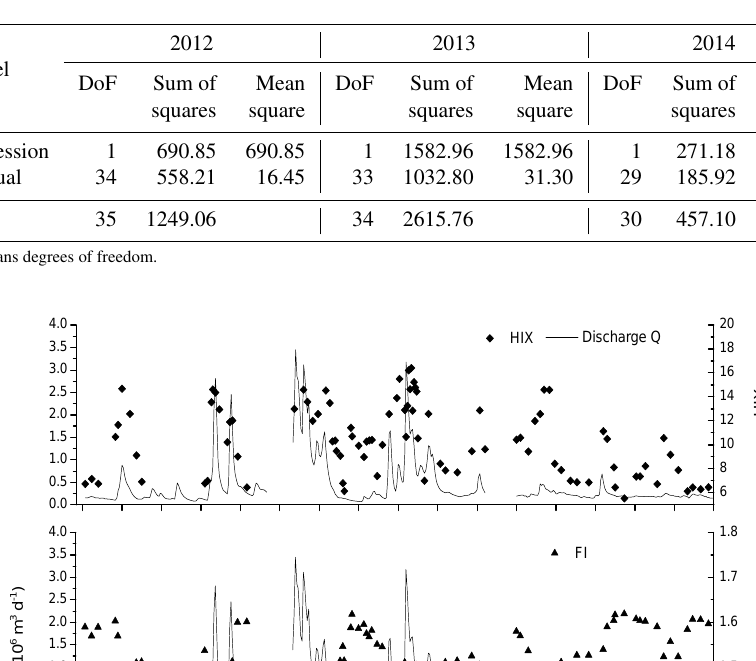
real regions. In our study, the annual mean concentration, 15.4 mg L − 1 , was in the middle of the range of concentra- tions reported from boreal regions, from 1.5 to 35.3 mg L −